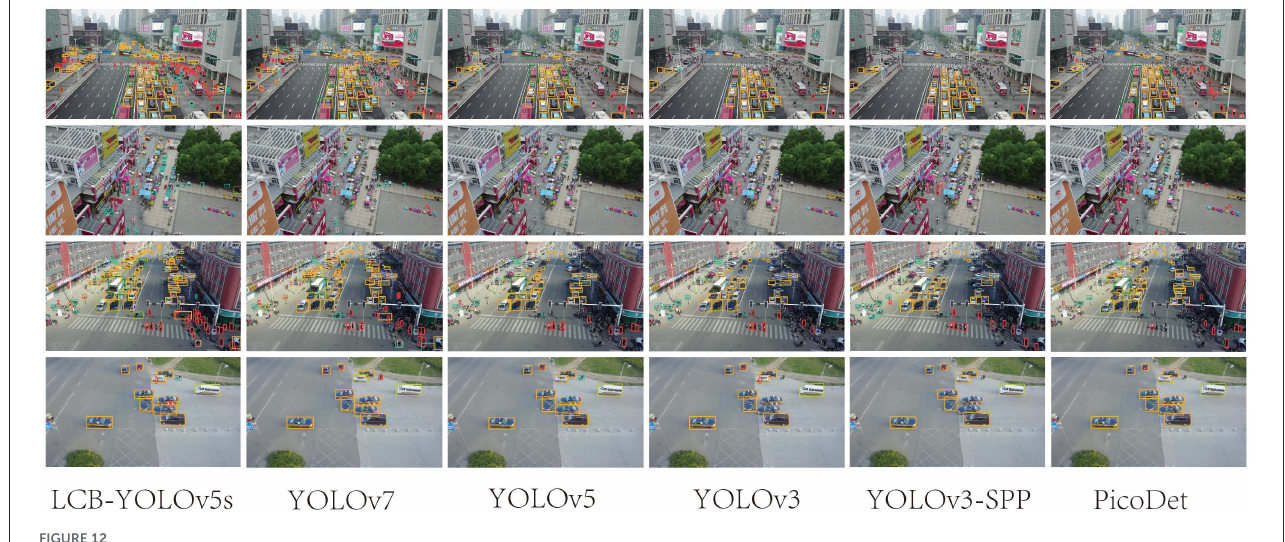
FIGURE12 Comparison of the target detection of six different models on the Visdrone2019 dataset.